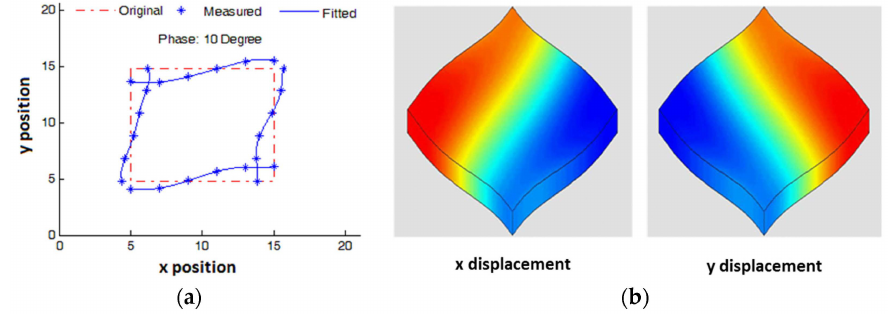
Figure 10. ( a ) Experimentally measured mode shape of a d 36 FS plate; and ( b ) corresponding simulated mode shapes with displacements along x and y directions mapped in colours.